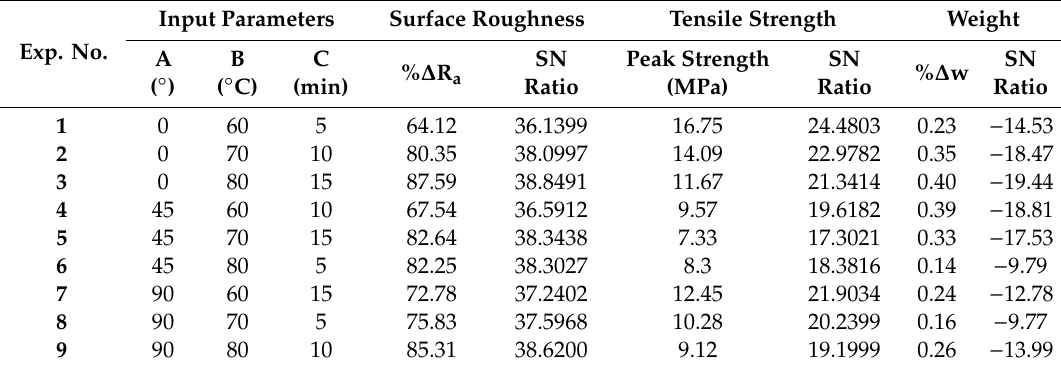
Table 1. Experimental control log with SN ratio of each